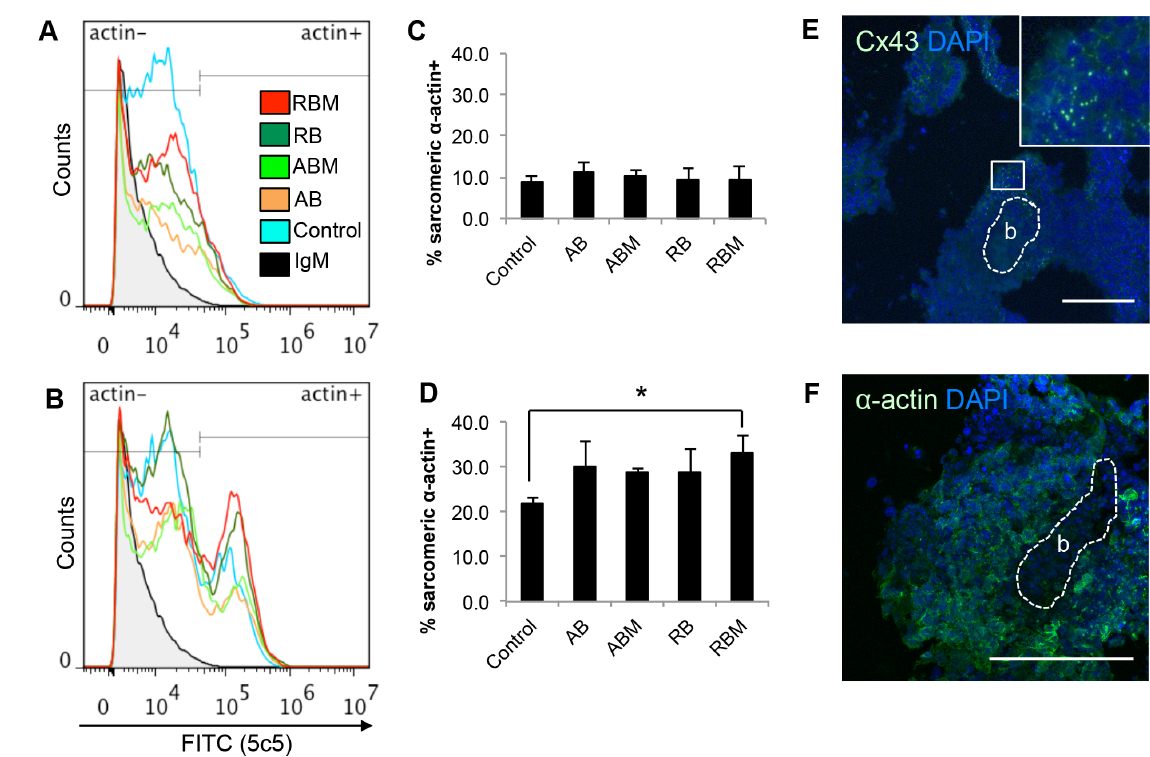
Fig. 7. Sarcomeric a -actin expression in Day 3-stimulated EBs. Histogram representation of sarcomeric a -actin + cells in Day 18 EBs without BMP4 (A) and with BMP4 (B). (C–D) Percent of sarcomeric a -actin cells in EBs without (C) and with (D) BMP4 supplementation. (E) Cx43 (inset: magnification of cx43 between cells) and (F) sarcomeric a -actin immunostaining of Day 3-stimulated EBs on Day 18. ‘‘b’’: location of beads within confocal micrograph. AB: AcLDL-Beads, RB: RGD-Beads, M: magnetized. * p , 0.05. Scale bar: 20 m